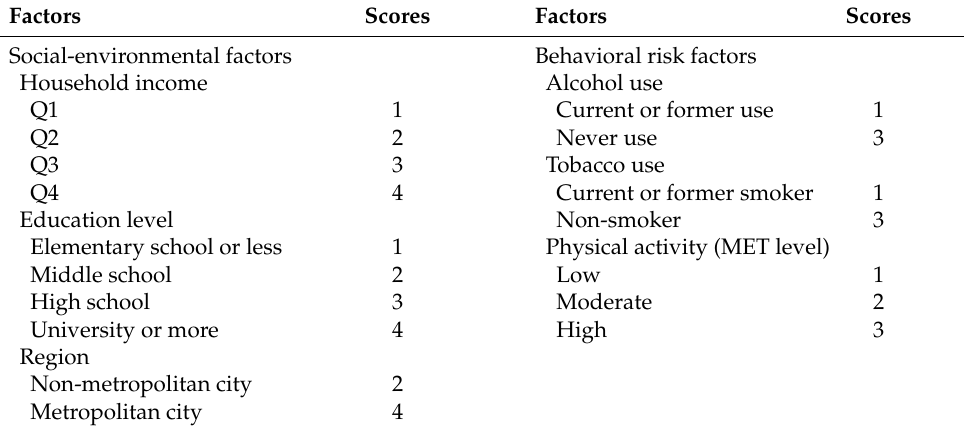
Figure A1. The distribution of the ratio scores. Table A1. Scores for each